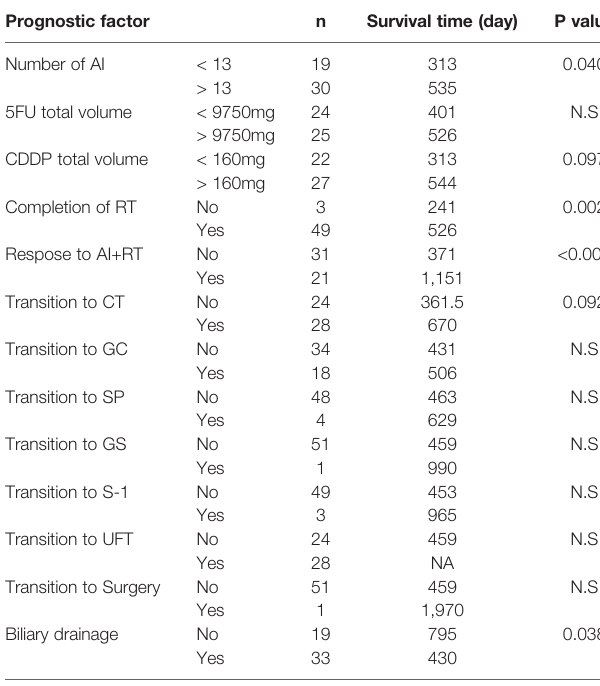
TABLE 3B | Prognostic factors in all BTCs: univariate analysis (therapy